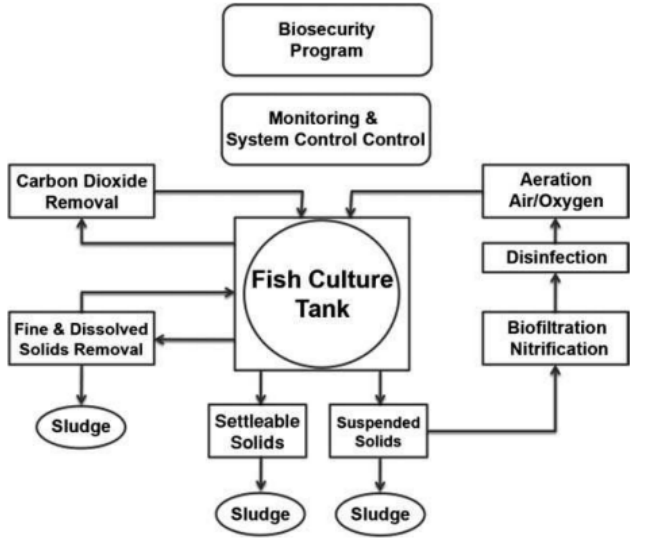
Figure 2. Unit processes used on a recirculating system. Source: Ebeling and Timmons [49] (p. 248).